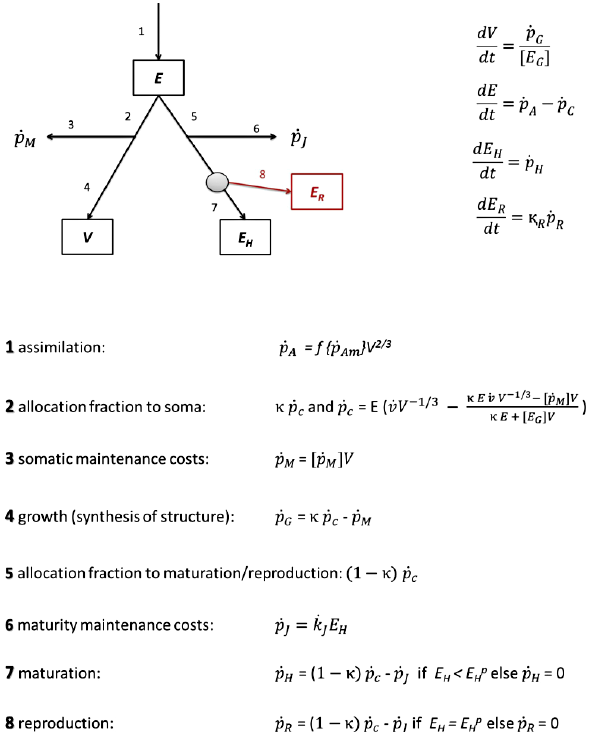
Figure 2. Energy flux scheme of the standard DEB model. Boxes: variables. Arrows: energy fluxes in Jday − 1 . The equations for each flux can be found below. Grey circle: metabolic switch associated with puberty: the individual stops allocating towards maturation and starts allocating towards puberty. E X : food ( J ), E P : faeces ( J ), E : reserve ( J ), V : volume of structure (cm 3 ), E H : cumulated energy invested in maturation, and E R : cumulated energy invested in repro- duction. The energy fluxes are functions of the model parameters which can be found in Table